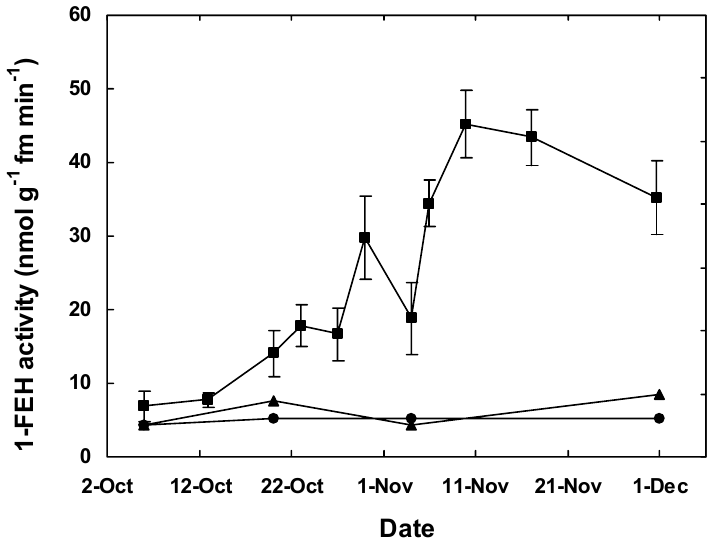
FIGURE 5 . Changes in 1-FEH activity in autumn chicory roots. Outside plants ( ■ ) and greenhouse plants with ( ▲ ) or without ( ♦ ) additional